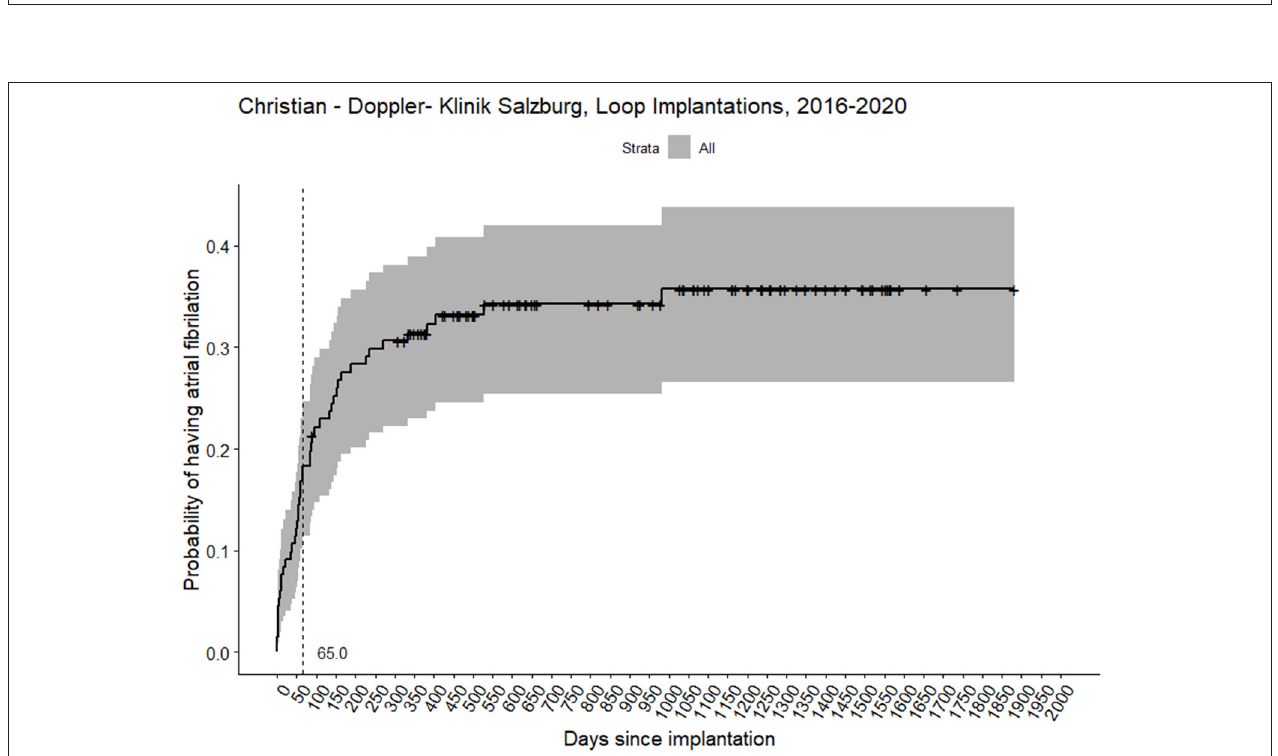
FIGURE 2 | Probability of having atrial fibrillation in 131 patients with the implanted loop recorder device. The vertical dashed line represents median days to atrial fibrillation detection. Crosses represent censored observations.